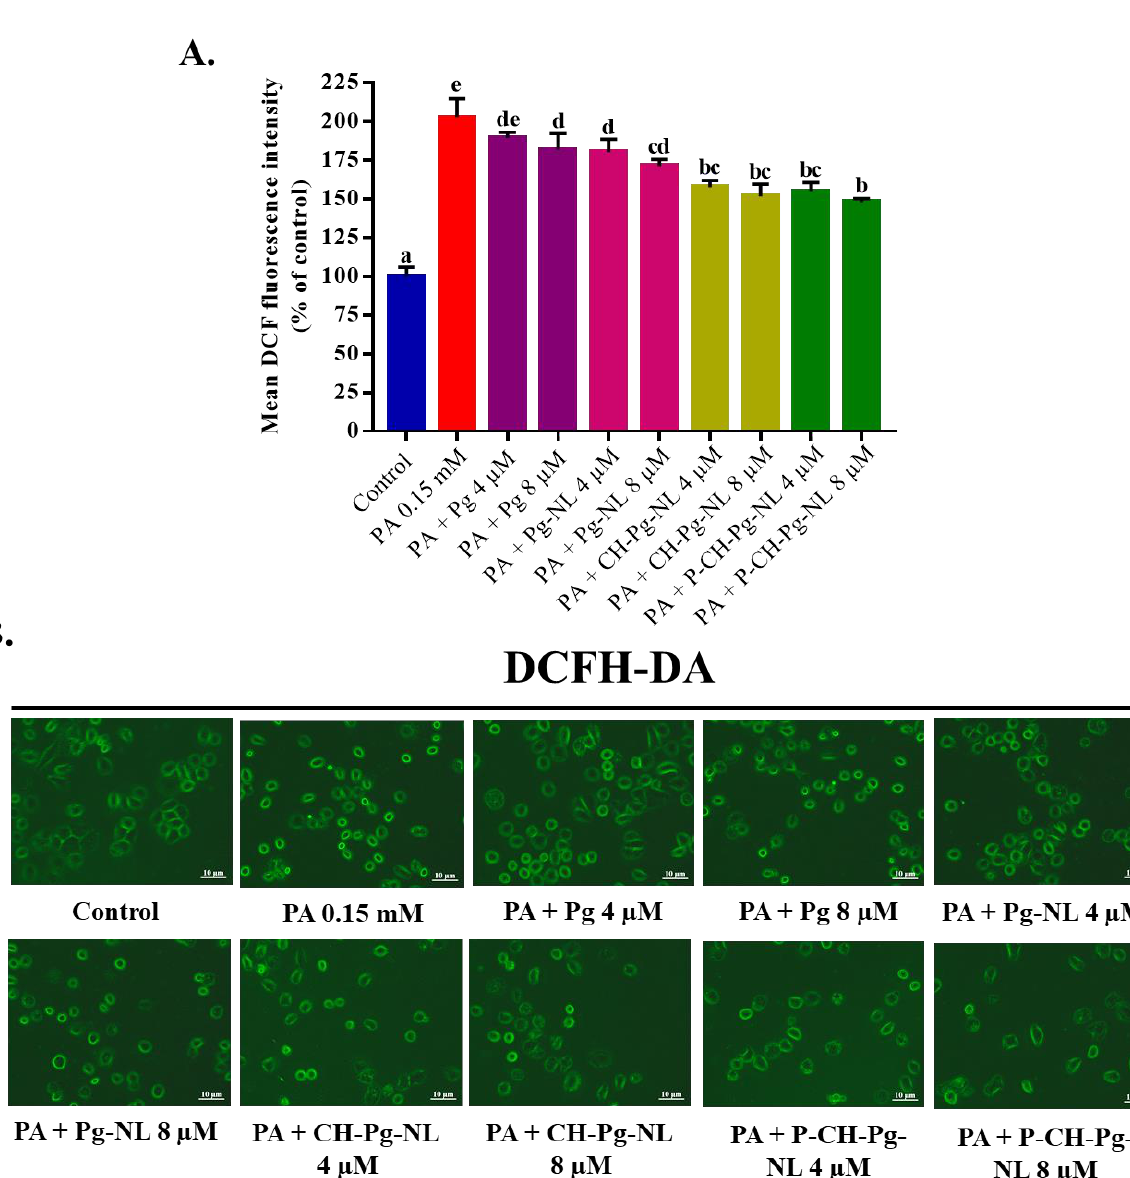
Figure 4. Effects of free Pg and Pg-loaded liposomal systems on PA-induced intracellular ROS pro- duction in L02 cells. ( A ) Quantitative determination of ROS as “% of mean DCF fluorescence inten- sity compared to control” . ( B ) Qualitative determination of ROS by “photographs of DCFH -DA flu- orescence intensity of different samples”. Individual alphabet represents the significant difference ( p < 0.05) of all treatment groups. Here, PA = palmitic acid; Pg-NL = Pelargonidin- 3-O -glucoside- coated by